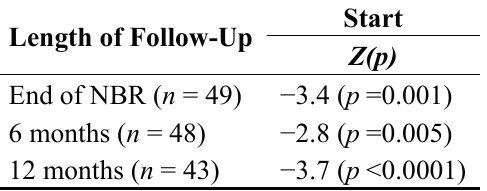
Table 4. Comparisons of the rank scores for BAI; comparing start of NBR with follow-up at the end of NBR and at six- and twelve-month follow-up, respectively. Length of Follow-Up